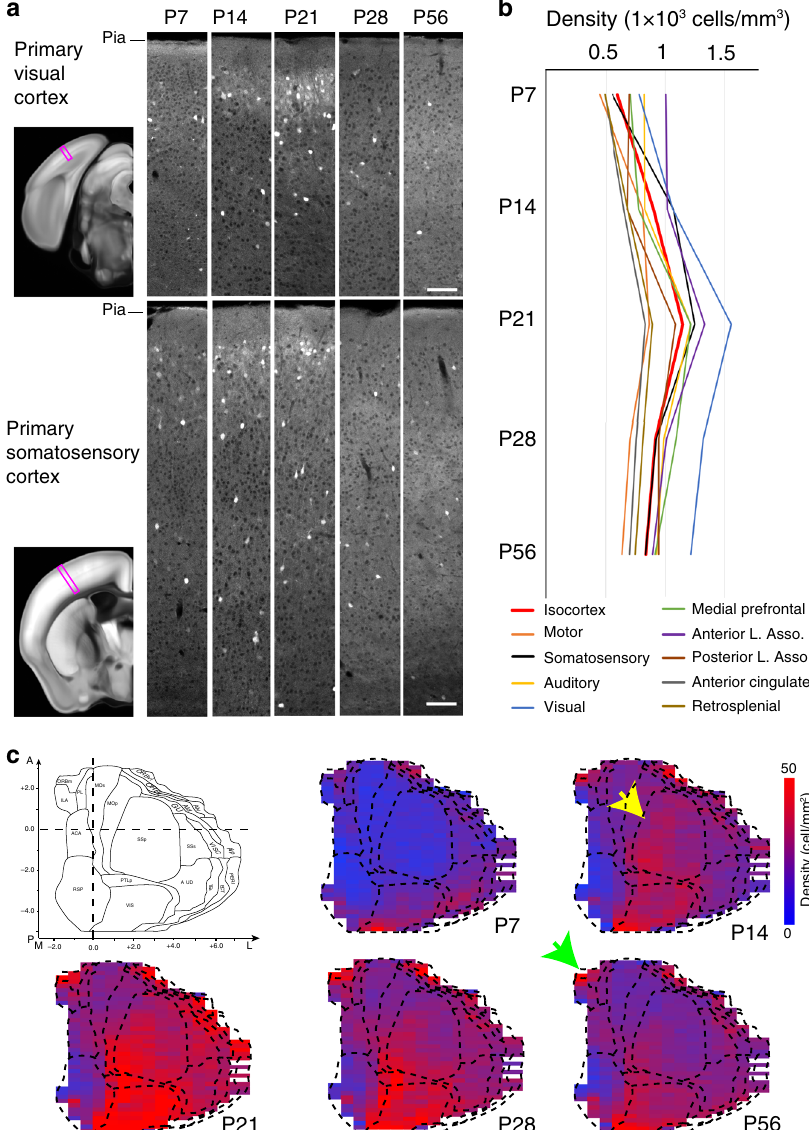
Fig. 3 Developmental trajectory of OTR cells in the isocortex from Otr-Venus mice. a Representative images from the primary visual and the primary somatosensory cortices (purple boxes) in Otr Venus/ + mice at P7, 14, 21, 28, and 56 (columns to the right). Note clustered and dispersed OTR expression in the super fi cial and deep cortical layers, respectively. Scale bars = 100 μ m. b Average densities of OTR-Venus cells in different isocortical areas at fi ve different postnatal ages. Anterior lateral (L) association (Asso) area for lateral orbital, gustatory, visceral, and agranular insular; posterior L. Asso. for temporal association, perirhinal, and ectorhinal cortex. See Supplementary Data 1 for more details. c 2D cortical fl atmap representation of OTR-Venus expression pattern at different developmental time points. The heat map represents OTR-Venus densities in evenly spaced bins in the cortical fl atmap. Note overall peak expression in all cortical regions at P21. See also Supplementary Fig. 3 for layer-speci fi c cortical fl atmaps. The yellow arrow at P14, and the green arrow at the P56 fl atmap highlights the somatosensory cortex and the medial prefrontal cortex, respectively. Full name of abbreviations can be found in Supplementary Data